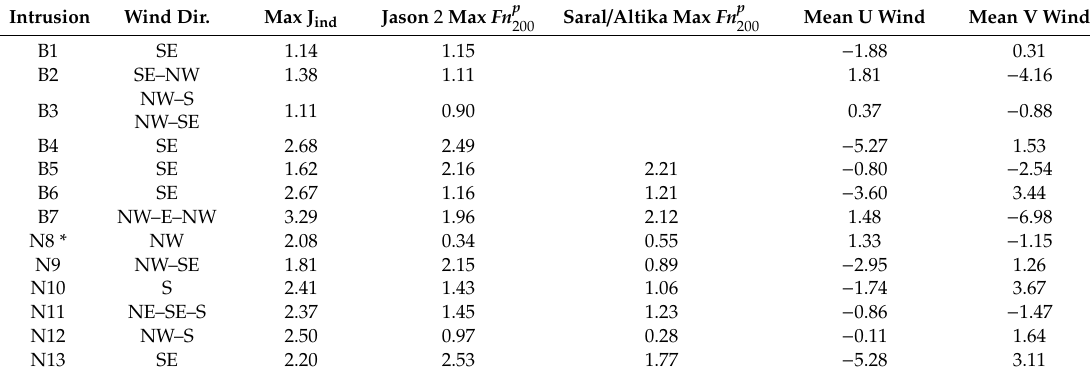
Figure 6. Same as Figure 5 for the period 17 July 2014–10 April 2015. Table 3. List of intrusions with the main wind direction, the maximum J ind during the intrusion, the maximum normalized flux from Jason 2 and Saral / Altika and the mean horizontal wind during the intrusion. Intrusions signed with a * are very fast (1–2